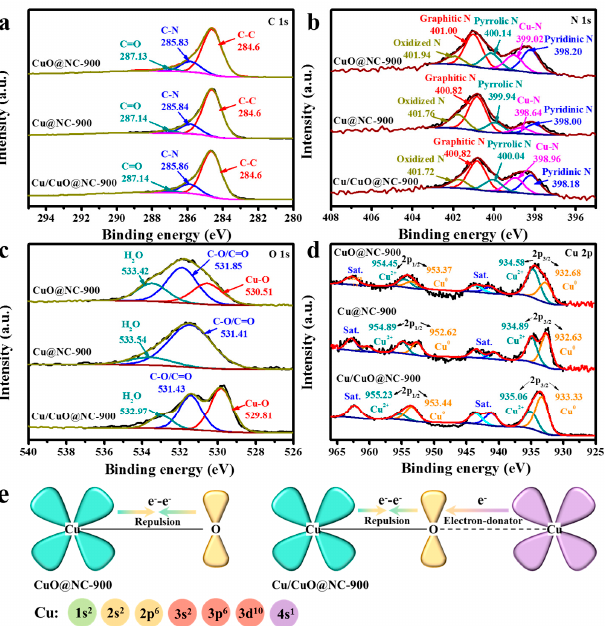
Figure 4. High-resolution XPS spectra of CuO@NC-900, Cu@NC-900, and Cu/CuO@NC-900 samples: ( a ) C 1s; ( b ) N 1s; ( c ) O 1s; ( d ) Cu 2p. ( e ) Schematic representations of the electronic coupling among Cu and O in CuO@NC-900 and Cu/CuO@NC-900.